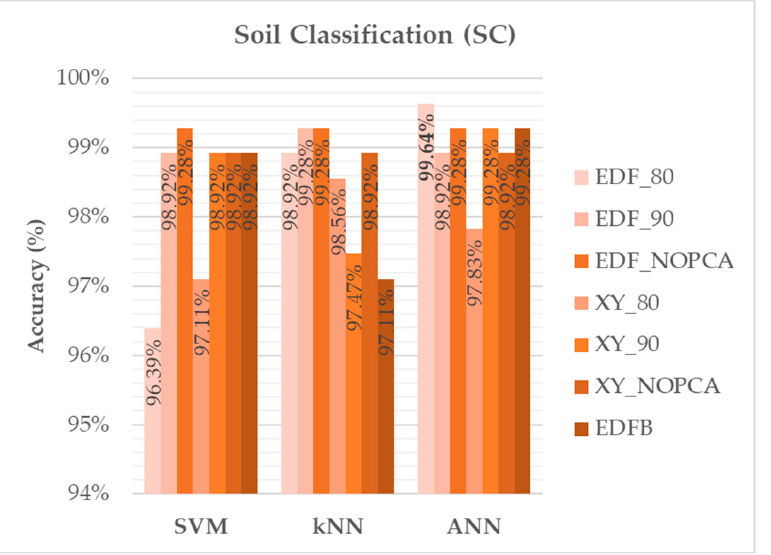
Figure 7. Classi fi cation EDF, XY, and EDFB machine learning model performance quanti fi ed by pre- Figure 7. Classification EDF, XY, and EDFB machine learning model performance quantified by diction accuracy for SC models. The color legends indicate di ff erent form of Location Information prediction accuracy for SC models. The color legends indicate different form of Location Information modeling and the di ff erent status of PCA applied on the models. modeling and the different status of PCA applied on the